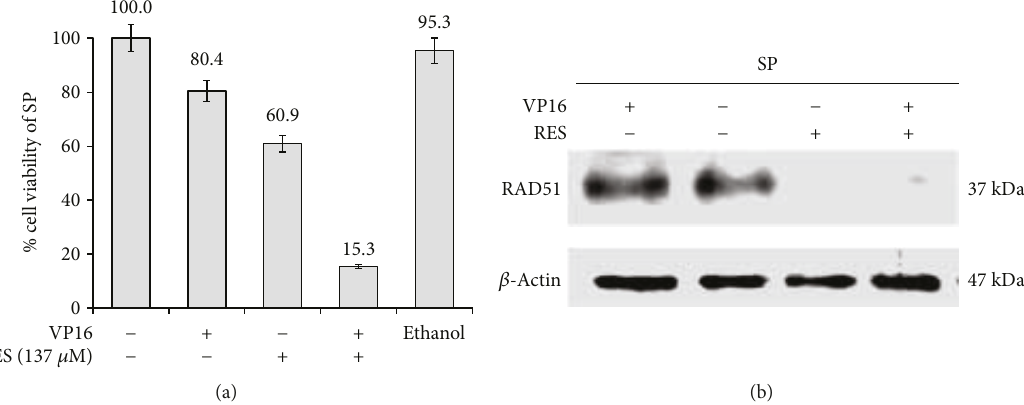
Figure 6: Resveratrol inhibits RAD51 expression in sphere cultures. (a) VP16 in the presence of RESveratrol (RES) decreases cell viability in HeLa SPhere (SP) cultures. Culture was exposed 72 h to both 5.8 μ g/mL VP16 and 137 μ M RES. Under these conditions, cell viability measured by MTT assay was strongly decreased (to 15.3%). Ethanol was used as vehicle control. (b) Western blot analysis shows that RES (137 μ M) treatment for 48h inhibited RAD51 protein expression (similar to siRAD51) in SP cultures as compared to HeLa SP without treatment or HeLa SP treated with Etoposide. RAD51 protein levels were highly reduced when HeLa SP were treated with resveratrol alone or together with Etoposide. Untreated MonoLayer (ML) HeLa cells were also used as a